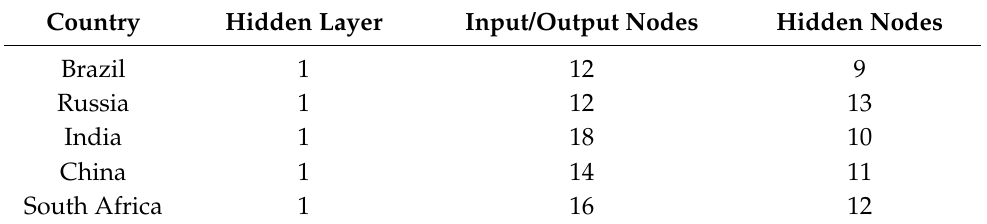
Table 2. Number of layers and neurons for each BRICS country assuring the best fitting performances. Country Hidden Layer Input/Output Nodes Hidden